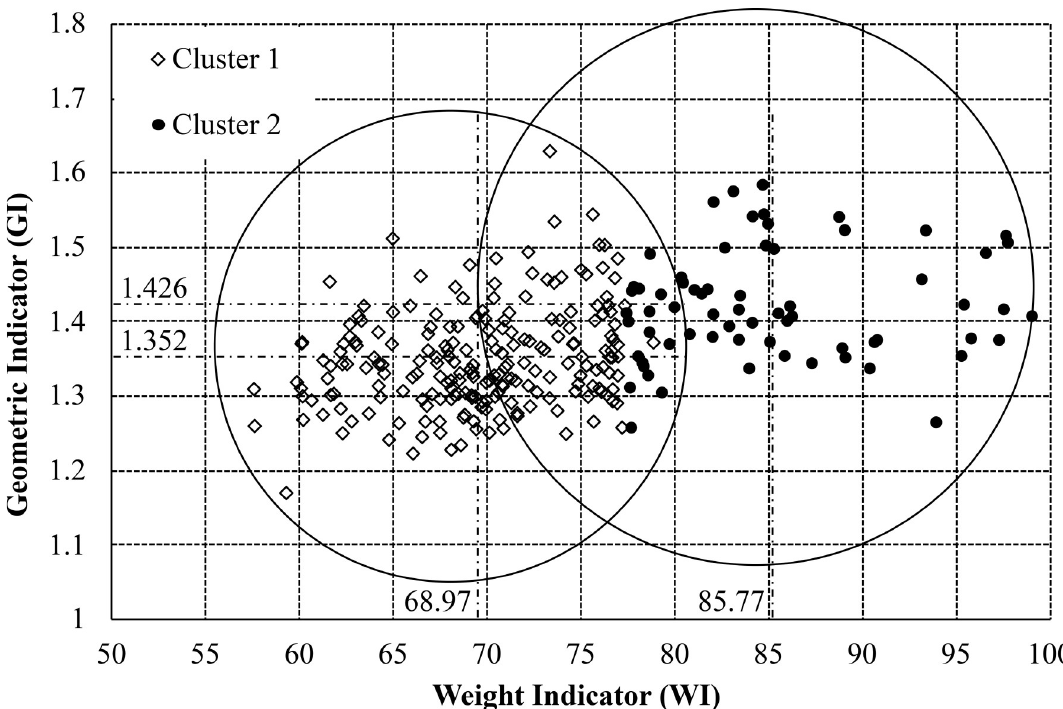
Fig 3. The points of SY and DY group in final iteration. The number of SY by K-means method were 210 eggs while the number of DY were 69 eggs.